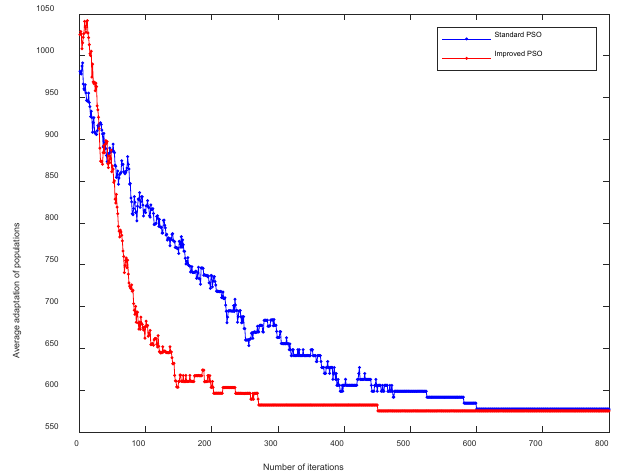
Figure 9. Comparison of the average adaptation of the improved PSO and the standard PSO during the iterative process.